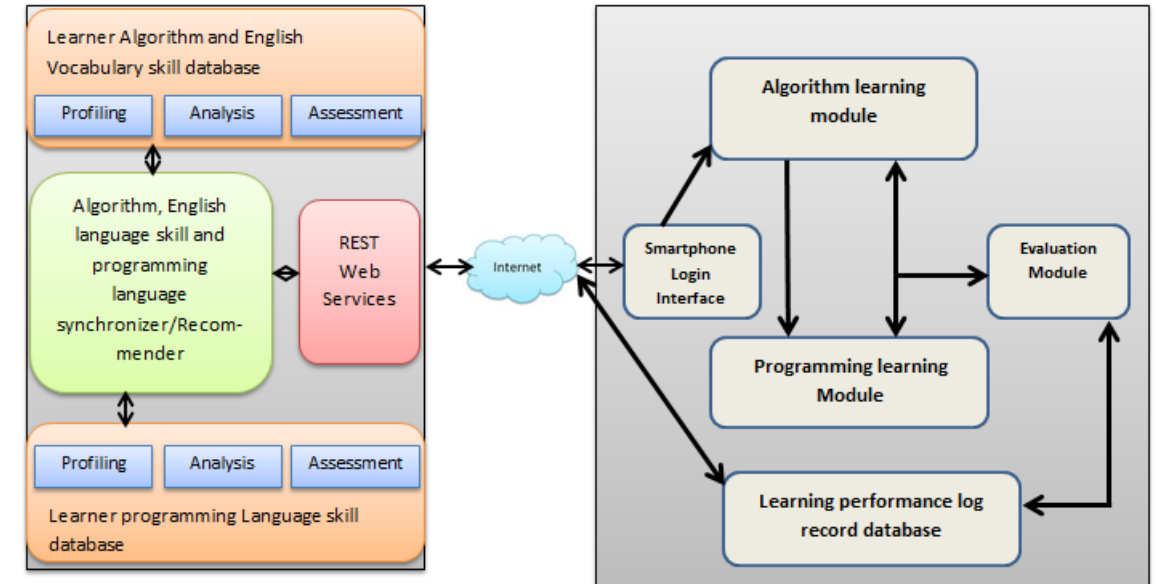
Figure 1. Working and architecture of Integrated English and Programming Language Learning System (IEPLS) students, the use of smartphone app was made very simple. Students just need their university registration number and any desired password to log and use the smartphone app. Algorithm Learning Module. Algorithm learning